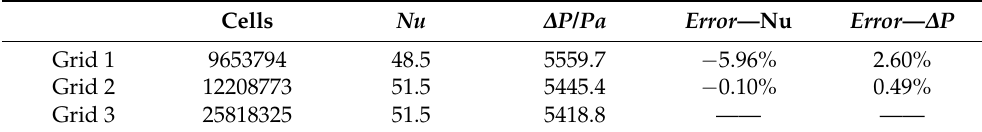
Table 2. Grid independence